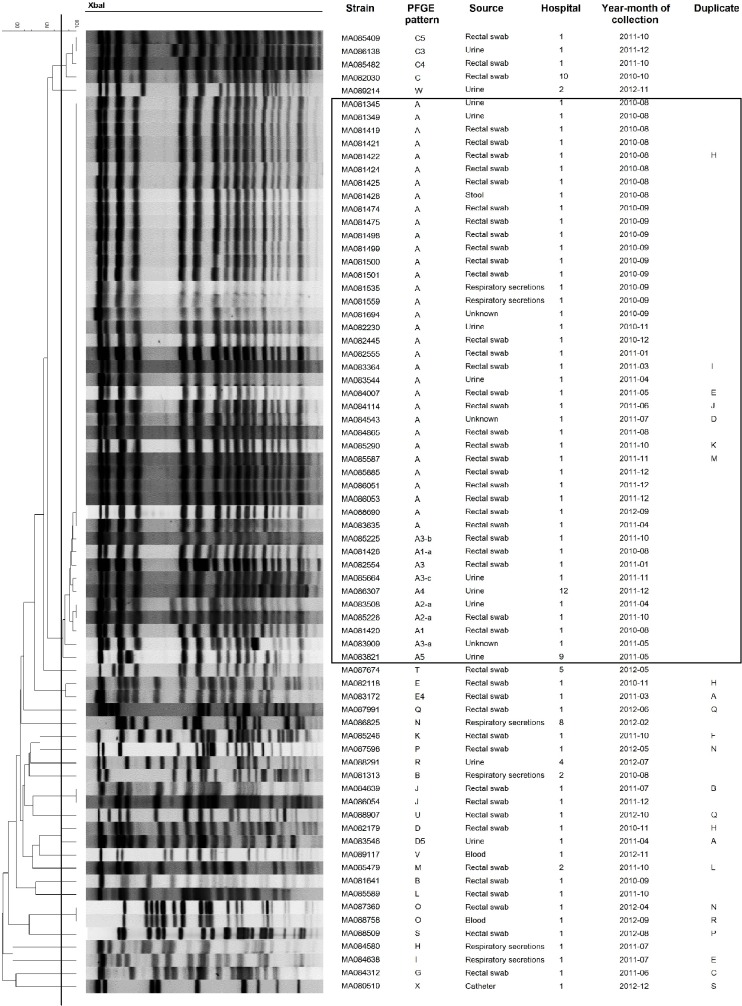
PFGE patterns of K. pneumoniae KPC strains (n = 73).One strain (MA084240) was untypable by XbaI. Black line in dendrogram represents percentage similarity cut-off. Box represents the main cluster within the species. Patients with more than one bacterial strain carrying KPC gene were identified as duplicate, following the same nomenclature through all figures.